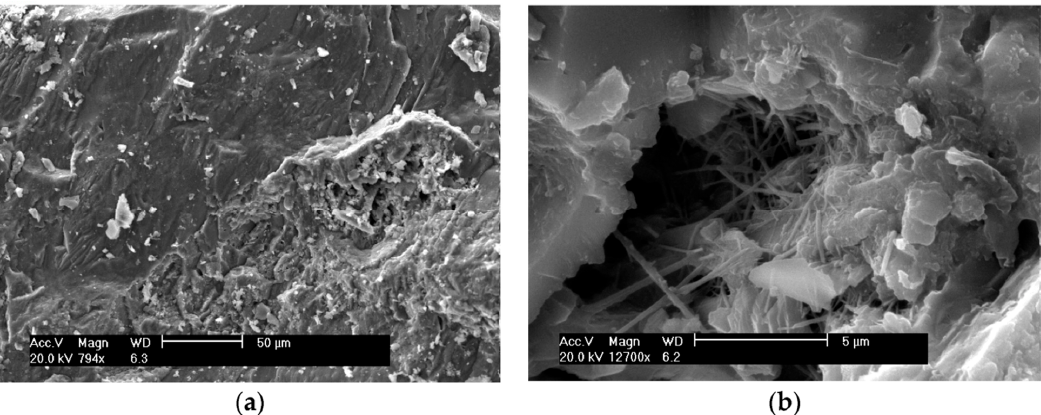
Figure 9. SEM images of concrete containing SF [83]. ( a )Global Image—100 µm ( b ) Detailed image 5µm